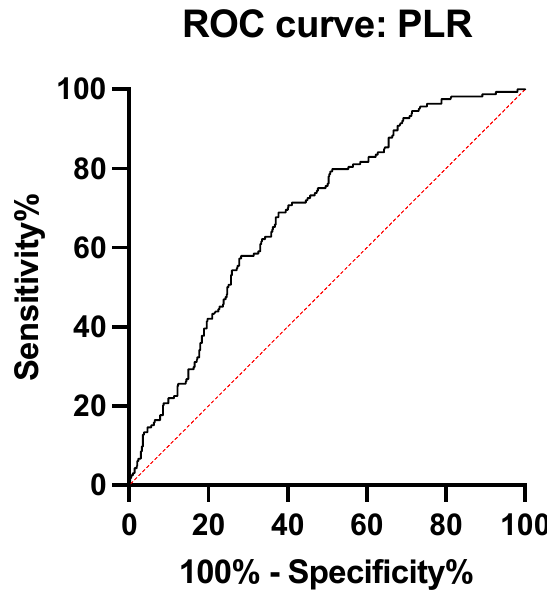
obtained an area under the curve = 0.68 (AUC), with 95% CI of 0.64 to 0.74, p < 0.0001. The cut-off point with the best sensitivity (63.41%) and specificity (64.14%) was 201.4 (Figure 2, Table 3). Figure 1. ROC curve neutrophil to lymphocyte ratio. Figure 1. ROC curve neutrophil to lymphocyte ratio.